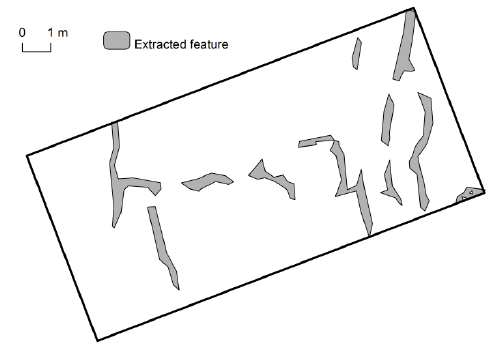
Looking at the red colour in the maps, related to the lower values of C min , it is possible to recognize the signature of the scarp highlighted in Figure 3 with yellow arrows, and also the likely unstable rock, indicated with a black arrow in Figure 6. Such features have been then extracted using multiple of 2 of C min .